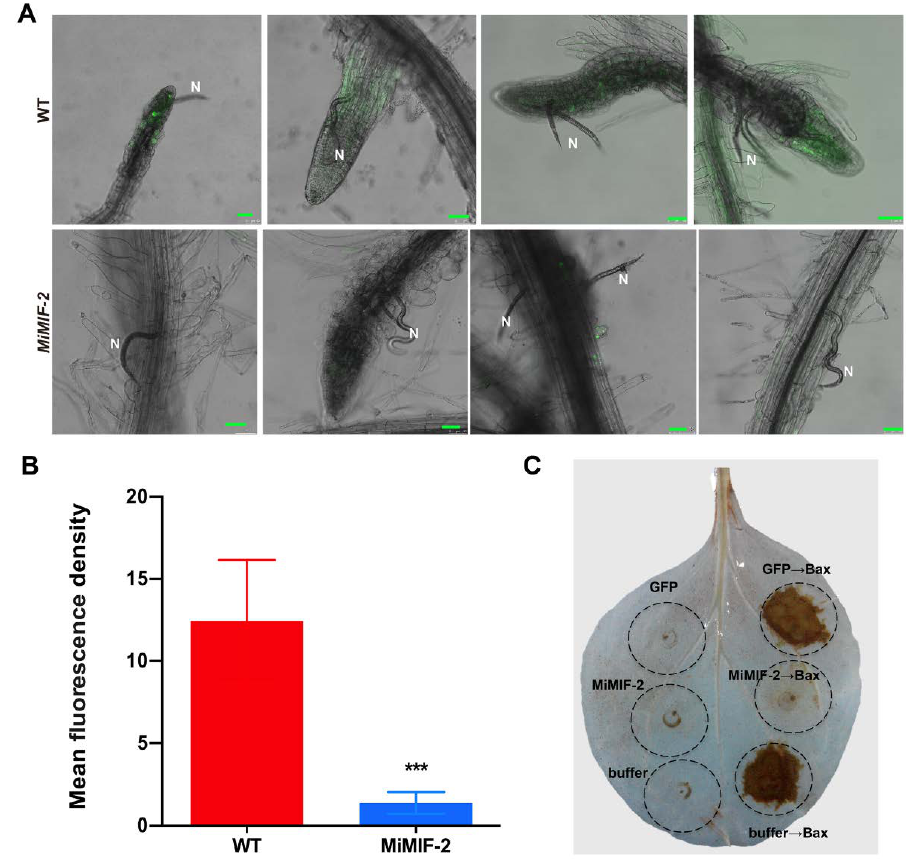
Figure 4. H 2 O 2 visualization in nematode infected Arabidopsis roots and H 2 O 2 detection after co-expression MiMIF-2 and Bax in N. benthamiana leaves; ( A ) CM-H 2 DCFDA staining of ROS in wild-type (WT) and MiMIF-2 expressing (MiMIF-2-3 and MiMIF-2-4) roots after M. incognita infection. Images were captured by confocal microscopy (LeicaSP8) 1-day post inoculation (dpi). Scale bar, 50 µ m. N, nematode; ( B ) Relative fluorescence density between wild type and MiMIF-2 expressing Arabidospsi after M. incognita infection. *** indicates significant di ff erence in the Student’s t -test ( p < 0.001). ( C ) H 2 O 2 production in N. benthamiana leaves was assessed by 3,3 (cid:48) -Diaminobenzidine (DAB) staining. N. benthamiana leaves were infiltrated with Agrobacterium tumefaciens carrying the corresponding constructs, and measurements were performed at 2 dpi. Three independent assays were conducted and at least 5 plants and / or 15 leaves were